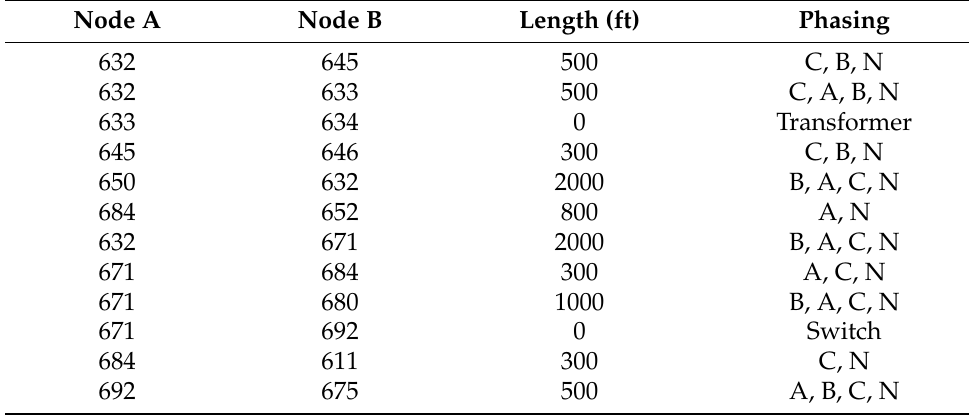
Table A2. IEEE 13 node test feeder Line Length and